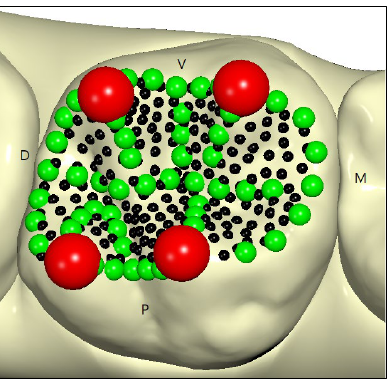
Figure 1. Distribution of landmarks (red points) and semilandmarks (blue, green, and black points) on the premolar occlusal surface.